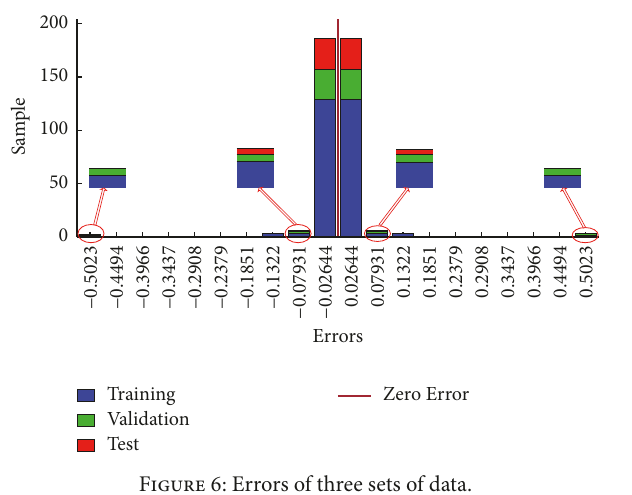
Figure 6: Errors of three sets of data.